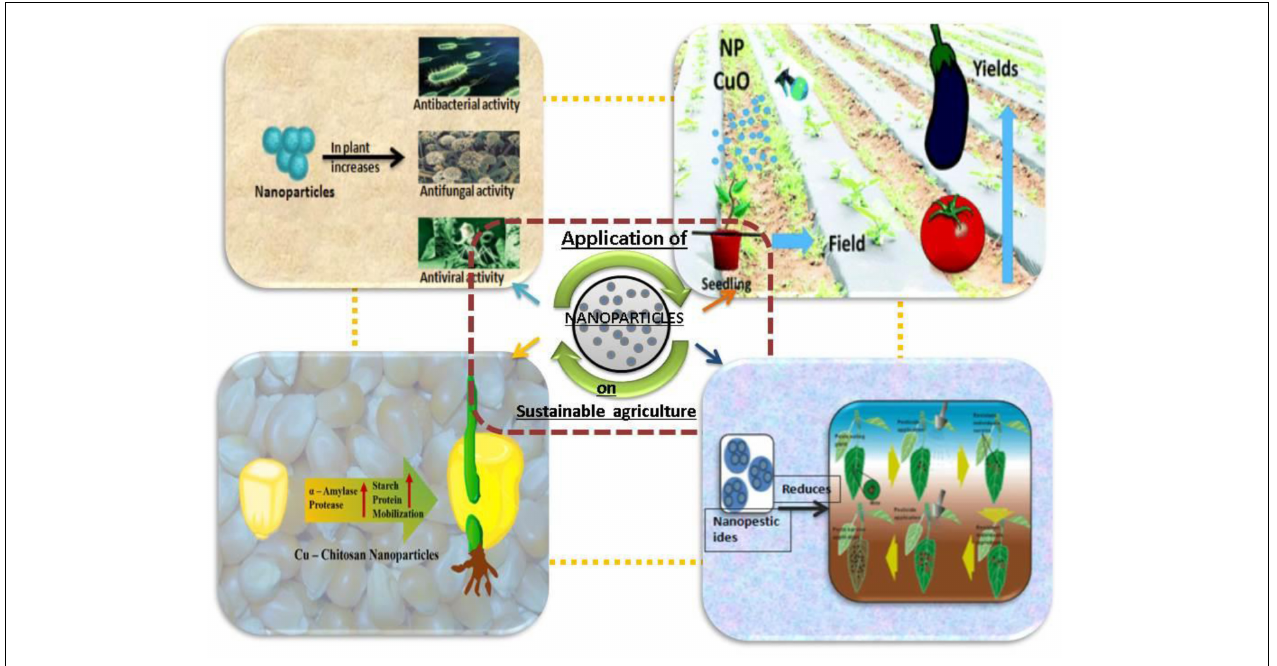
FIGURE 3 | Potential applications of nanotechnology representing the consequences of nanoparticles in sustainable agriculture.